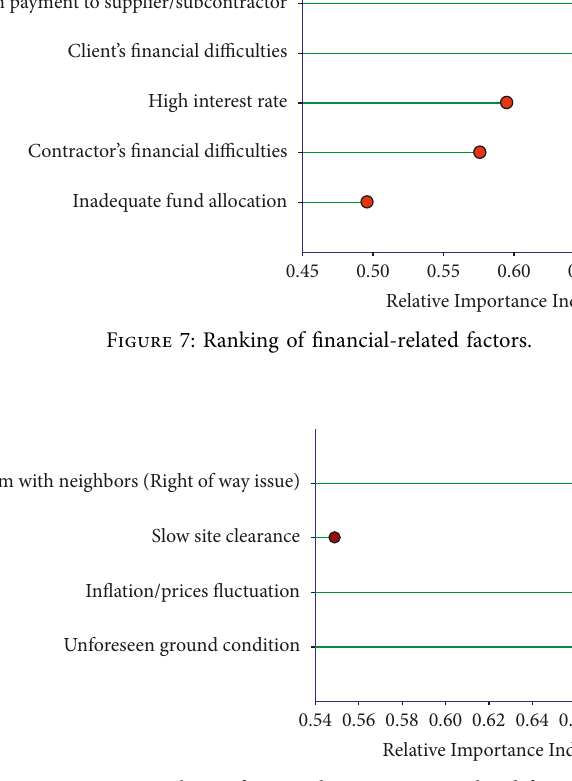
Figure 8: Ranking of external environment-related factors.